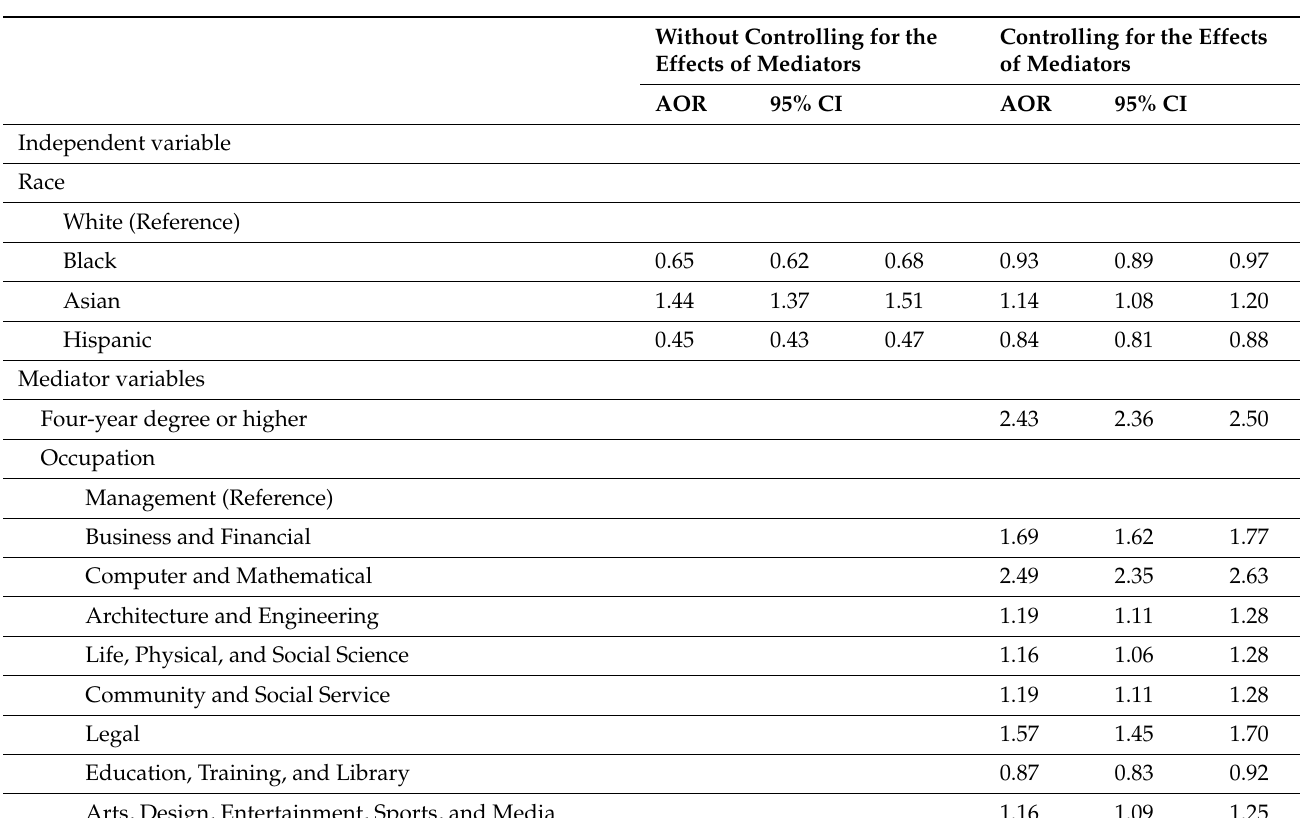
Table 2. Association between teleworking and race.